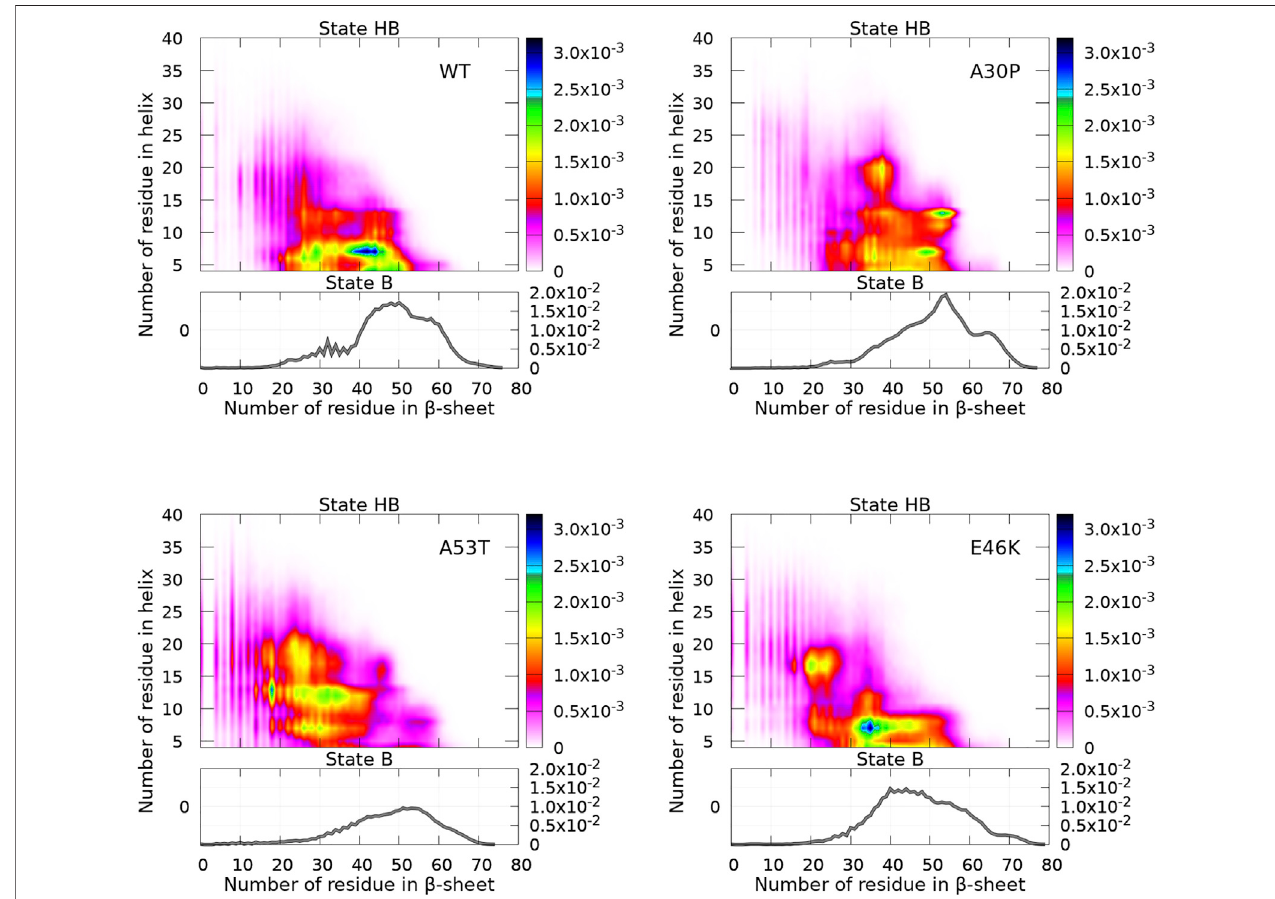
FIGURE 4 | Probability density of the number of residues in the α -helix and β -sheet for WT and mutants of α -syn. The probability density of state B (no helix) is represented by a function (gray) (right vertical axis), and the probability density of state HB is represented by a two-dimensional map (right color bar).